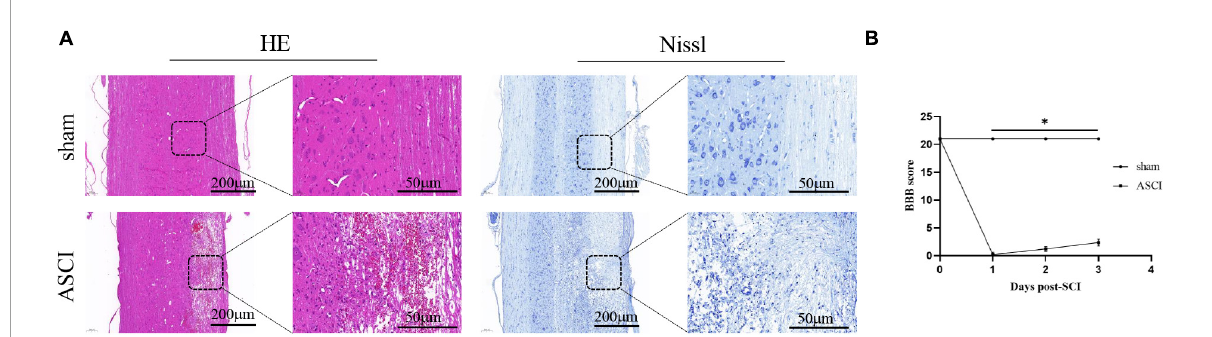
FIGURE1 Motor function and histology results during the acute-phase spinal cord injury. (A) HE and Nissl staining of the spinal cord horizontally after spinal cord injury. (B) Motor function deficits after spinal cord injury were assessed by Basso, Beattie, and Bresnahan Locomotor Scores (data were presented as means ± standard deviation, n = 14, Student’s unpaired t -test at different time point, ∗ P < 0.05, sham vs. the acute-phase spinal cord injury). Scale bar = 200/50 µ m, applicable to all corresponding sections. BBB, Basso, Beattie, and Bresnahan Locomotor Scores; ASCI, the acute-phase spinal cord